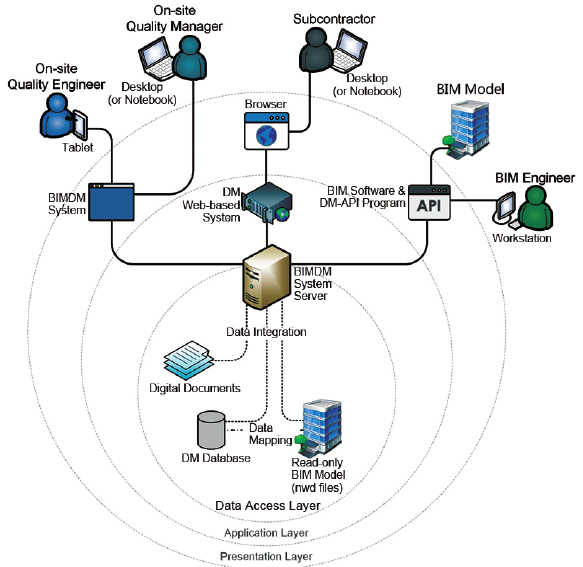
Fig. 2. System concept overview of the BIMDM